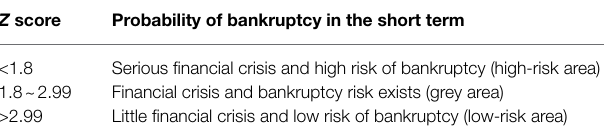
TABLE 14 | Calculation results of Z value of Haier.